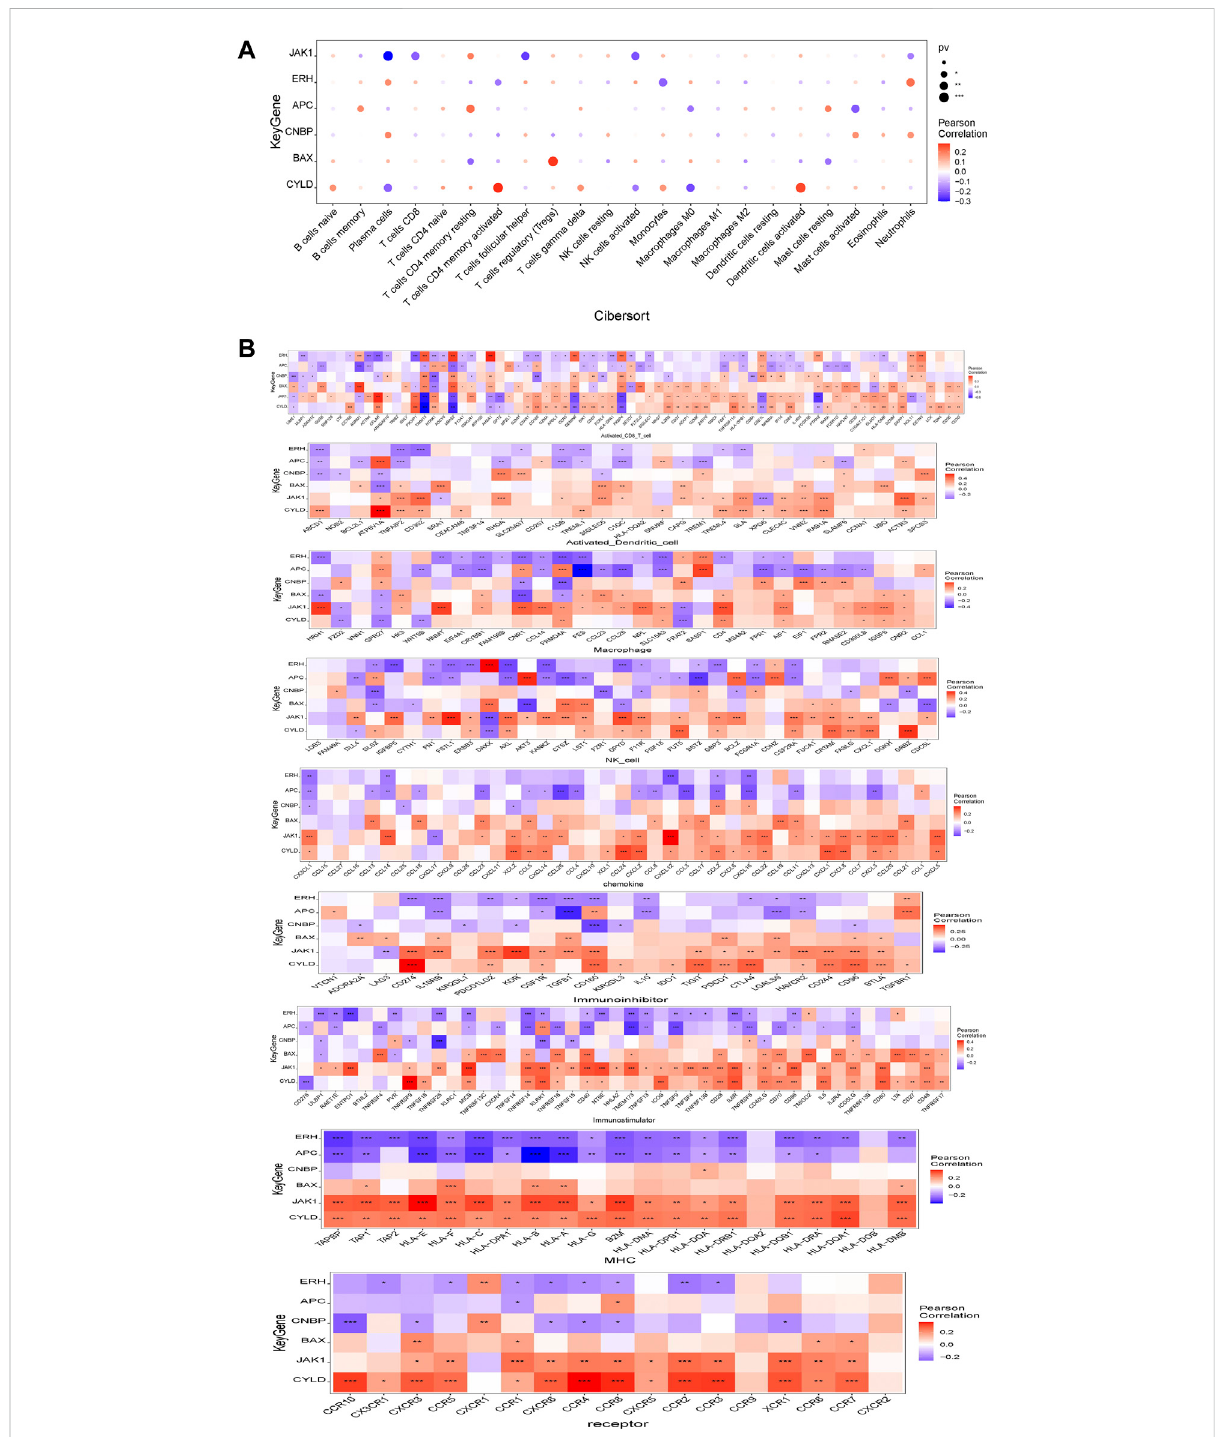
FIGURE 7 Relationship between model gene and immune in fi ltration. (A) Pearson correlation between model genes and 22 kinds of immune cells; (B) Pearsoncorrelationanalysisbetweenmodelgenesandvariousimmune-relatedgenes.*means p < 0.05;**means p < 0.01;***means p <